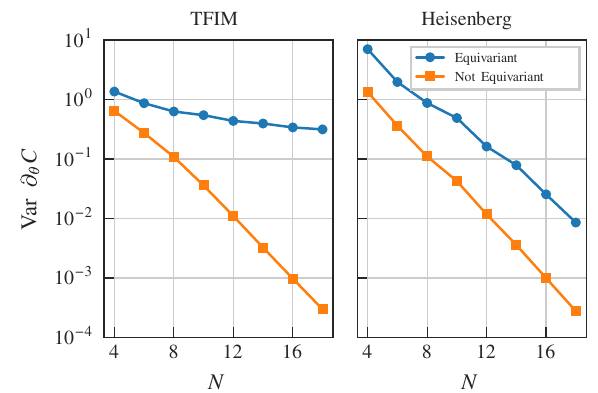
FIG. 11. Comparison of the barren plateaus phenomenon for the TFIM and the Heisenberg model considered in Figs. 9 and 10. The derivative is computed with respect to the rotation angle of the first qubit in the first layer using as the observable Z 1 Z 2 with p = 80 for the TFIM and p = 40 for the Heisenberg model. The variance is calculated using 1000 randomly sampled parameters from a uniform distribution [0, 2 π ].